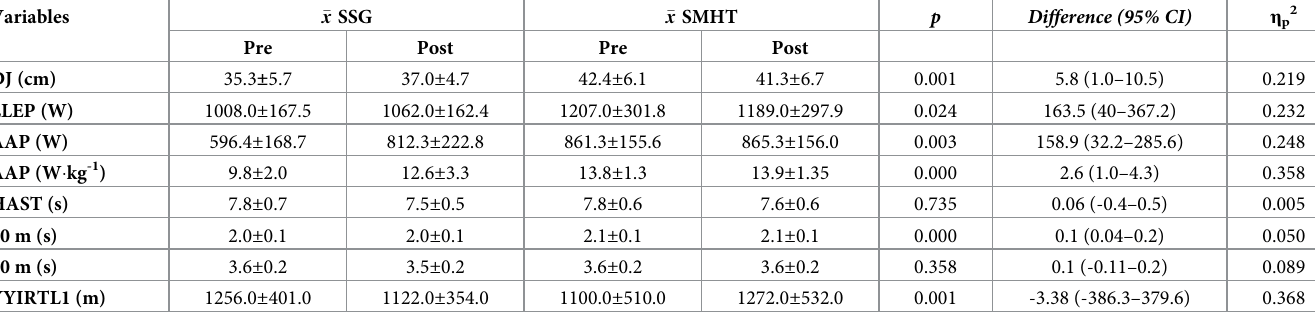
Table 2. Effect of SSG and SMHT training methods on fitness characteristics of the participants. Variables